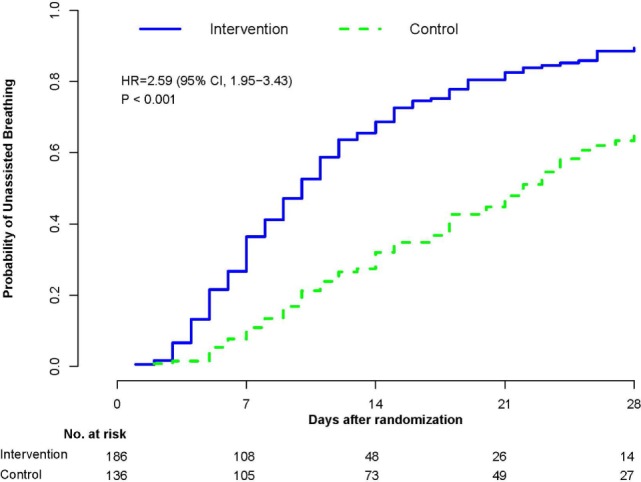
Probability of achieving unassisted breathing from randomization (methylprednisolone vs. placebo) to hospital discharge or day 28. Estimated cumulative incidence of achieving (initial) unassisted breathing by day 28 for patients with ARDS (n = 322) receiving either prolonged methylprednisolone treatment (blue solid line) or usual care (green dashed line). Death before achieving unassisted breathing is considered a competing risk. By day 28, the methylprednisolone group achieved initial UAB earlier (12.4 ± 0.61 vs. 19.8 ± 0.78 days; HR 2.59, 95% CI 1.95–3.43, p < 0.001). Reproduced with permission (58).